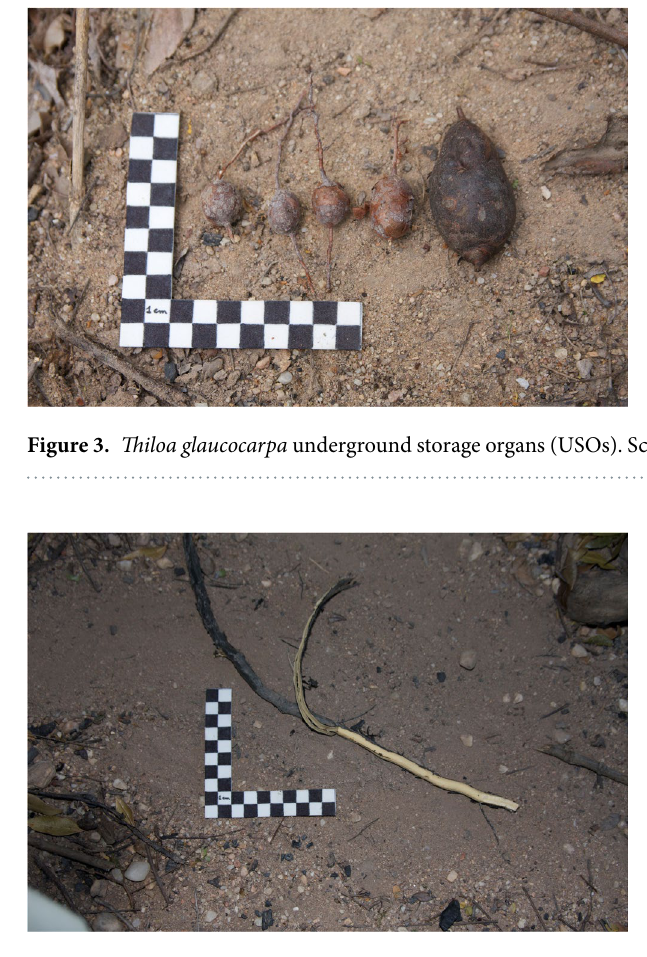
Figure 4. Louro tree root ( Ocotea sp), with peeled skin. Scale: 10